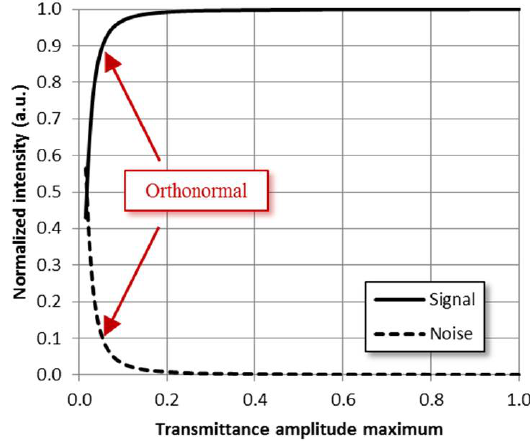
Figure 7. Signal and noise intensity evolution as a function of the maximum value in the transmittance function (Equation (7)) for the configuration case shown in Figure 6.